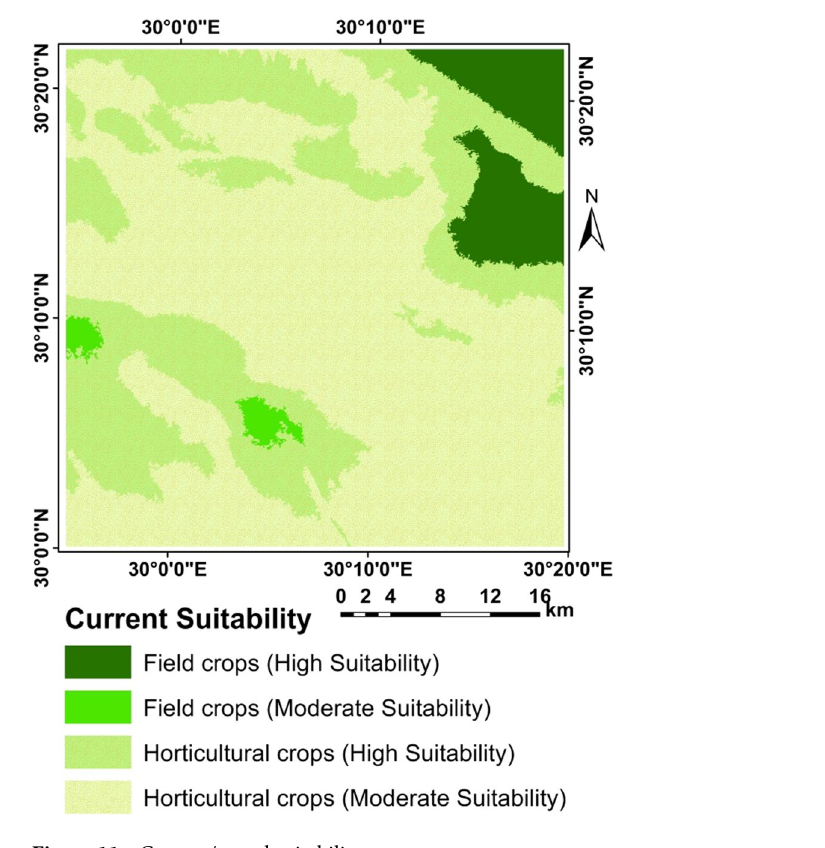
Figure 11. Current/actual